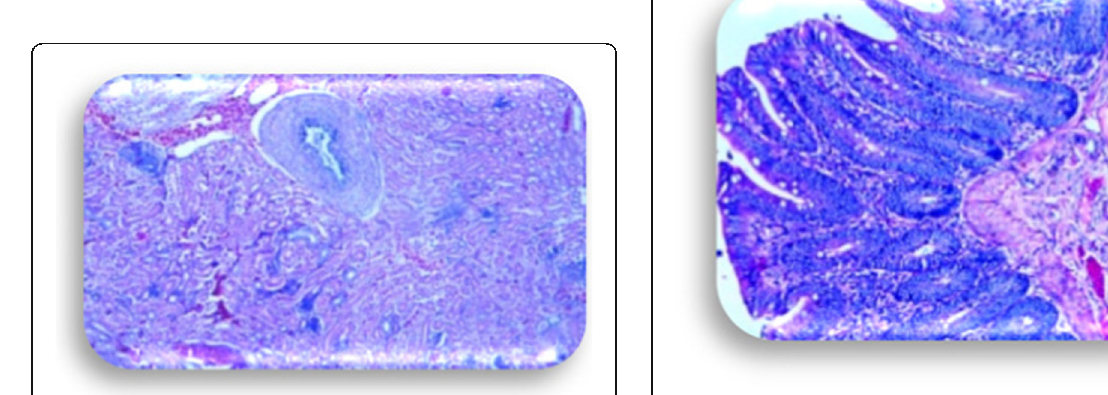
Fig. 10 Activation of goblet cell and leukocytic infiltration in the mucosa and congested blood vessel for chicken group fed on 15% cactus